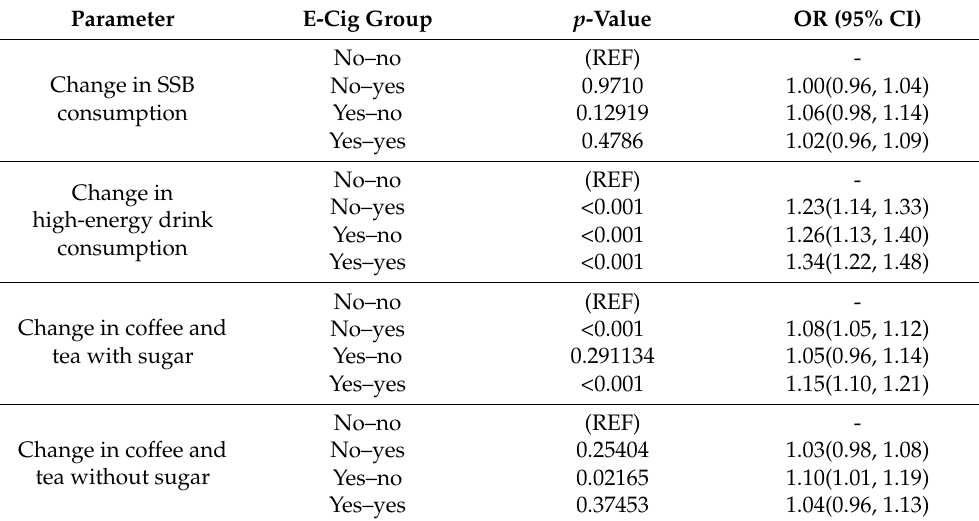
Table 6. Model 2: Longitudinal association between change in beverage consumption (2016/17– 2017/18) and vaping initiation (2016/17–2017/18) in the COMPASS